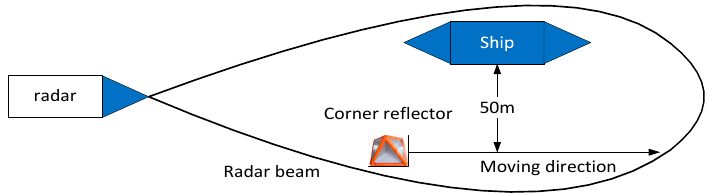
Figure 6. Scenario of data acquisition experiment.